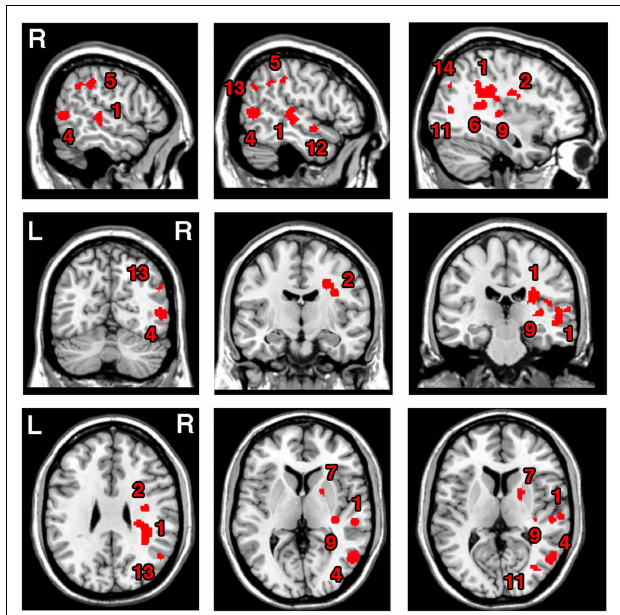
FIGURE 2 | Significant clusters identified in Analysis 1 (ALE meta-analysis, p < 0.05, FDR corrected for multiple comparisons, cluster size > 200mm 3 ) – the convergence between results from different lesion-symptom mapping studies concerned with neuroanatomy of the unilateral visual neglect syndrome. The numbers denote indentified ALE clusters as listed in Table 2